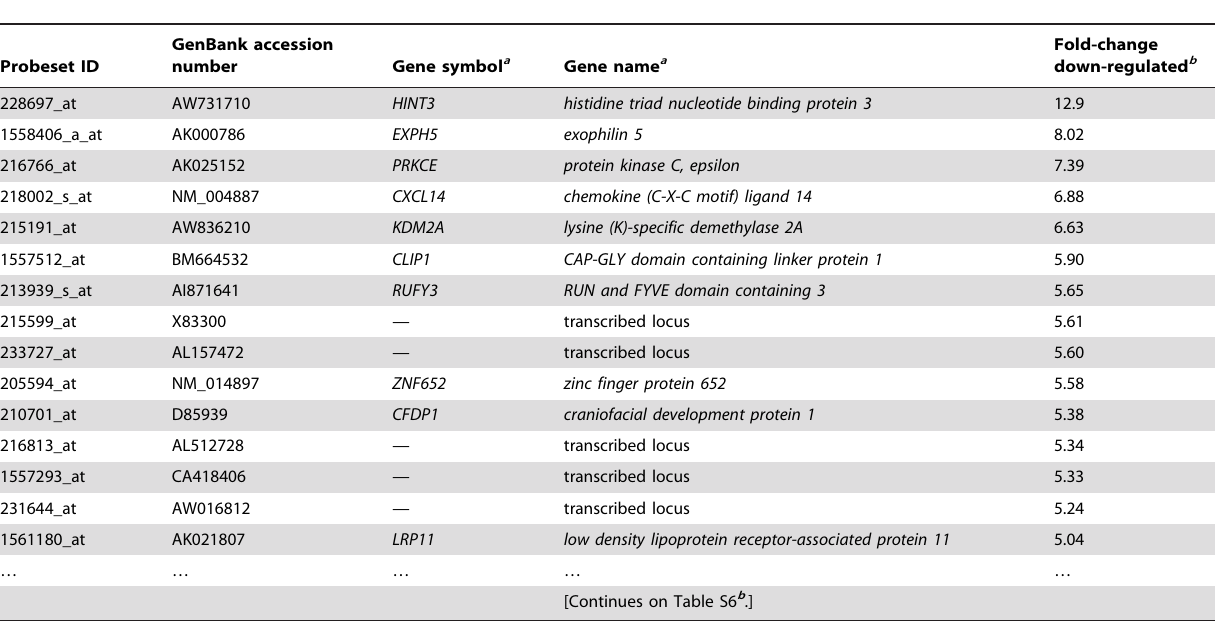
Table 4. RNA transcripts that were down-regulated in the SPB placentas, relative to the STB placentas, according to the microarray experiment (Mann-Whitney test, adjusted by the Benjamini and Hochberg method, adjusted p , 0.05).